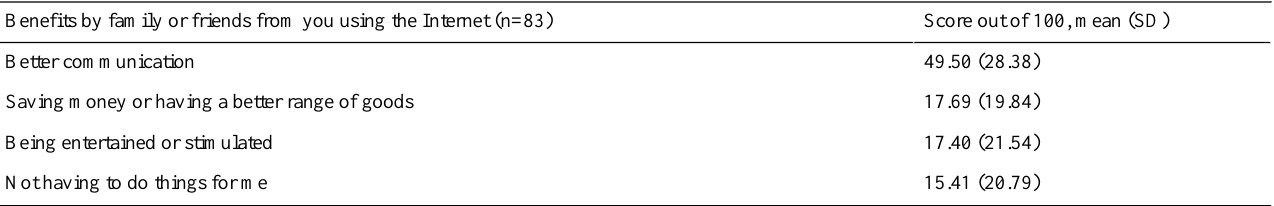
Table 5. Perceived value for family members of older person’s Internet use based on answers to question 2 from the Value of Participation postal survey: Have your family or friends benefited from you using the